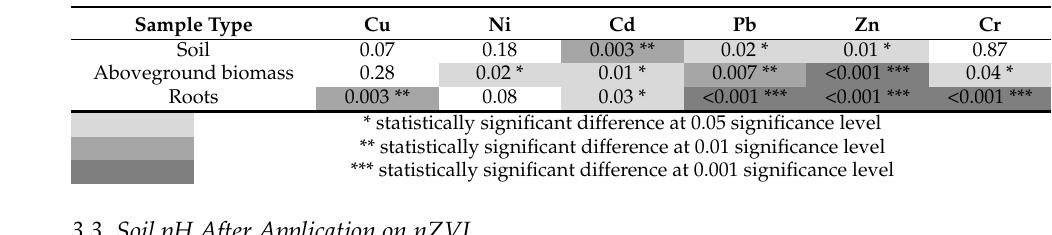
Figure 2. Accumulation of PTEs in soil after the experiment ( ■ Control ■ nZVI). For a given PTE, different letters indicate significant differences in PTE content in control soil and nZVI-amended soil. Table 2. The results of Tukey’s HSD test for PTE contents in soil, aboveground biomass, and roots between control and nZVI.